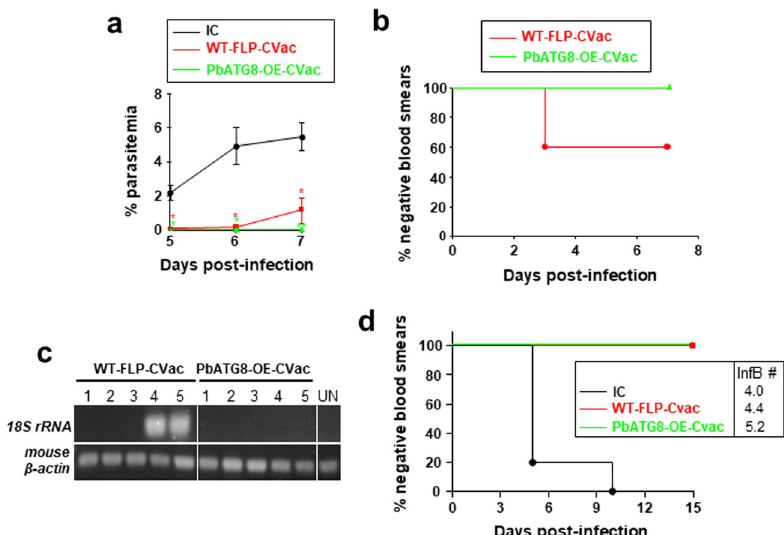
Fig. 5 PbATG8-OE-CVac-immunized mice are sterilely protected at memory time points. a Percent parasitemia during memory challenge. Swiss-Webster mice immunized with 2 × 10 4 WT-FLP-CVac or PbATG8-OE-CVac were challenged on D80 post-immunization with 10 4 WT-Pb- ANKA sporozoites to monitor parasitemia from D5 post-challenge. Data are means ± SD of fi ve mice in each group (* p < 0.005; ** p < 0.0001, measured by multiple t -test). b Prepatent period during challenge. Blood (0.1 ml) from challenged (on D80) mice were transferred on D15 post-challenge to recipient naïve mice to monitor the parasitemia for 15 days ( p < 0.05, measured by log-rank Mantel – Cox test). c PCR veri fi cation on blood from the infected mice at D80, with the ampli fi cation of 130 bp of Pb18S rRNA gene and mouse β -actin (control). Genomic DNA isolated from uninfected mice (UN) was used as a negative control. d Challenge with mosquito bites. A separate group of immunized mice ( n = 5 per group) were challenged WT-Pb-ANKA sporozoites through mosquito bite at D80. Mice from IC group received an average of four infectious bites (InfB), WT-FLP-CVac-immunized mice 4.4 InfB and PbATG8-OE-CVac-immunized mice 5.2